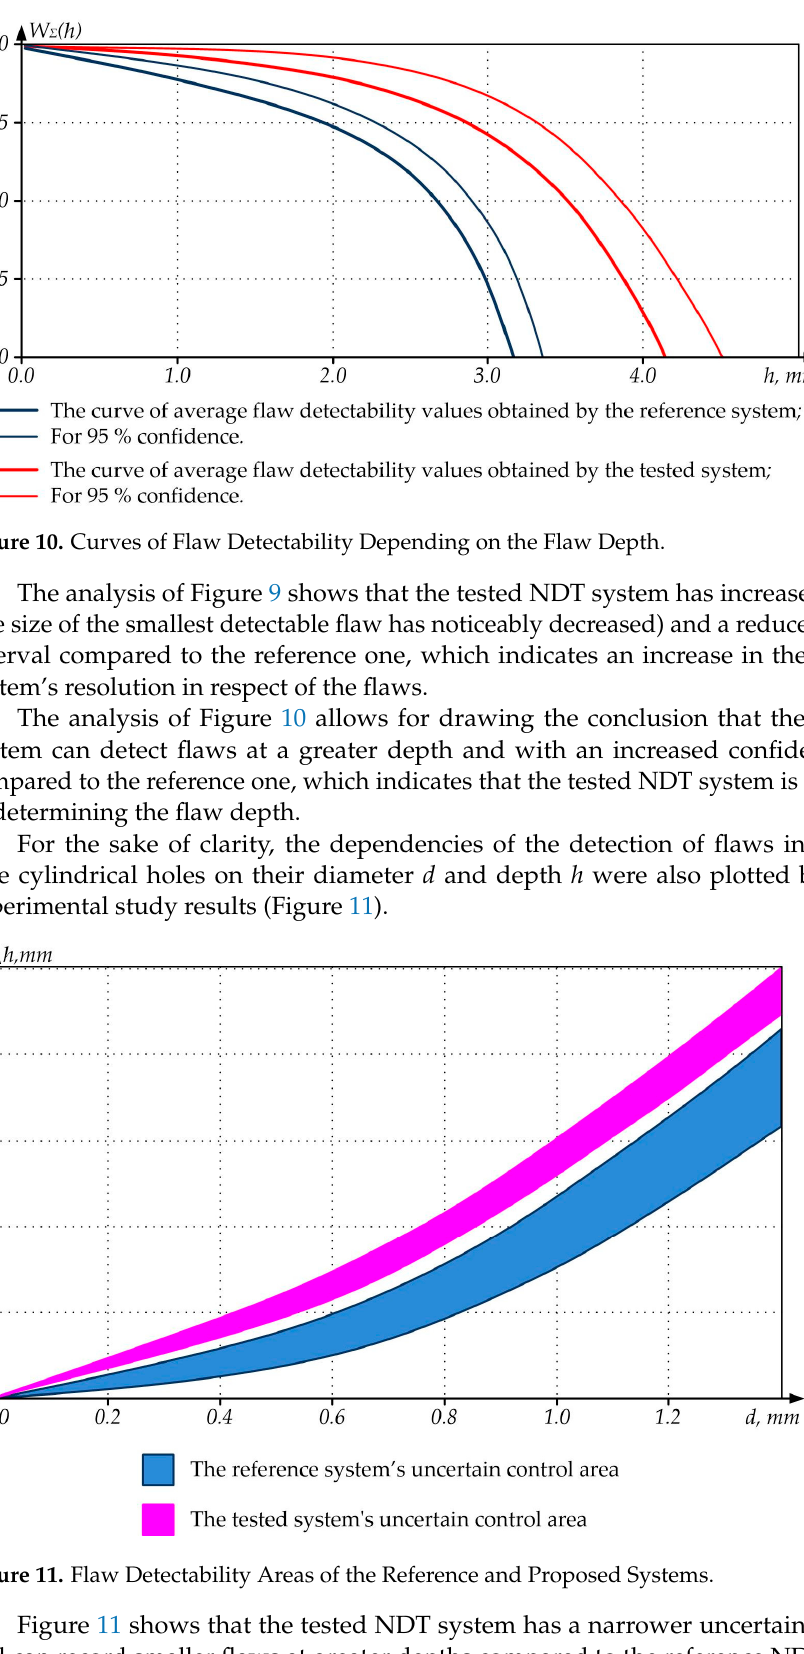
Figure 9. Curves of Flaw Detectability Depending on the Flaw Diameter.